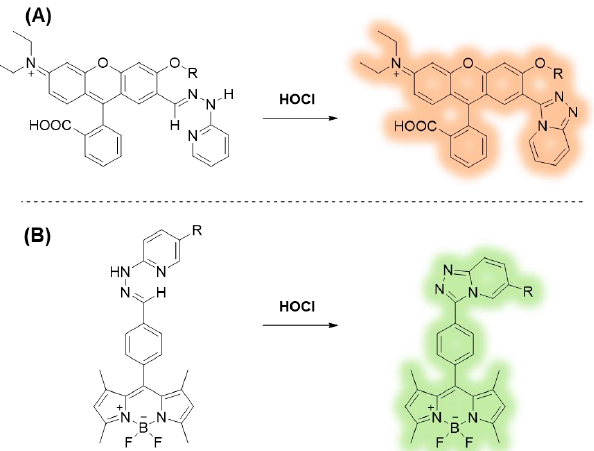
Figure 1. HOCl-triggered triazolopyridine formation reactions of the rhodol backbone in the literature ( A ) and the BODIPY backbone in this work ( B ).